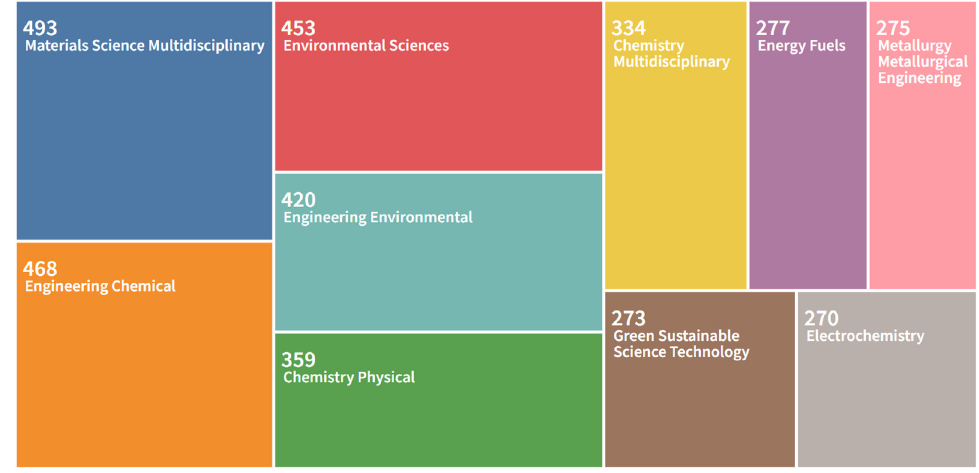
Figure 9. Top 10 journals with published LIB recycling articles.